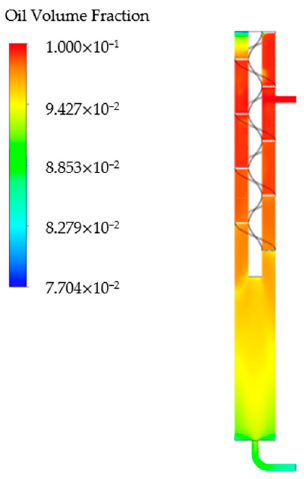
Figure 6. Oil phase volume distribution of the spiral orbit.